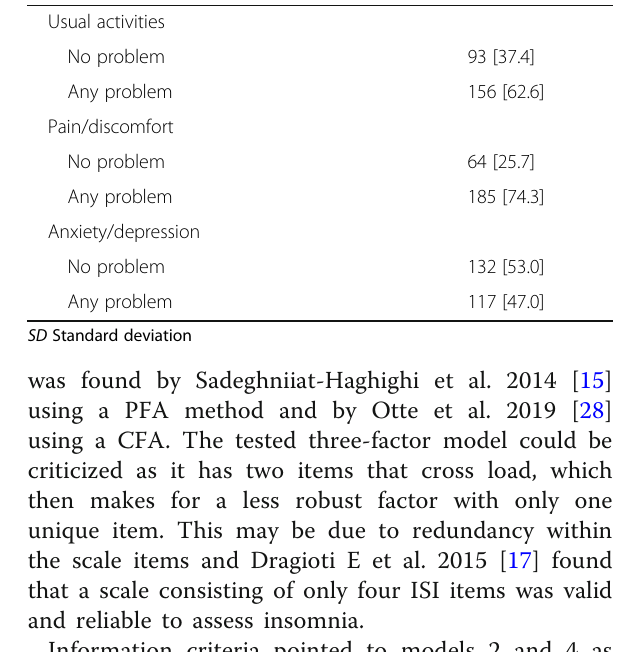
Table 1 Data on demographics, Insomnia Severity Index and